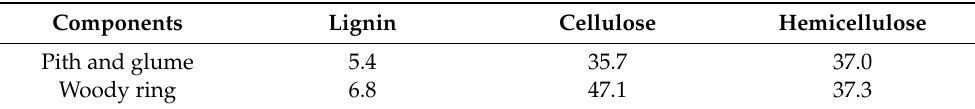
Table 5. Fiber composition of corn cob (%, dry